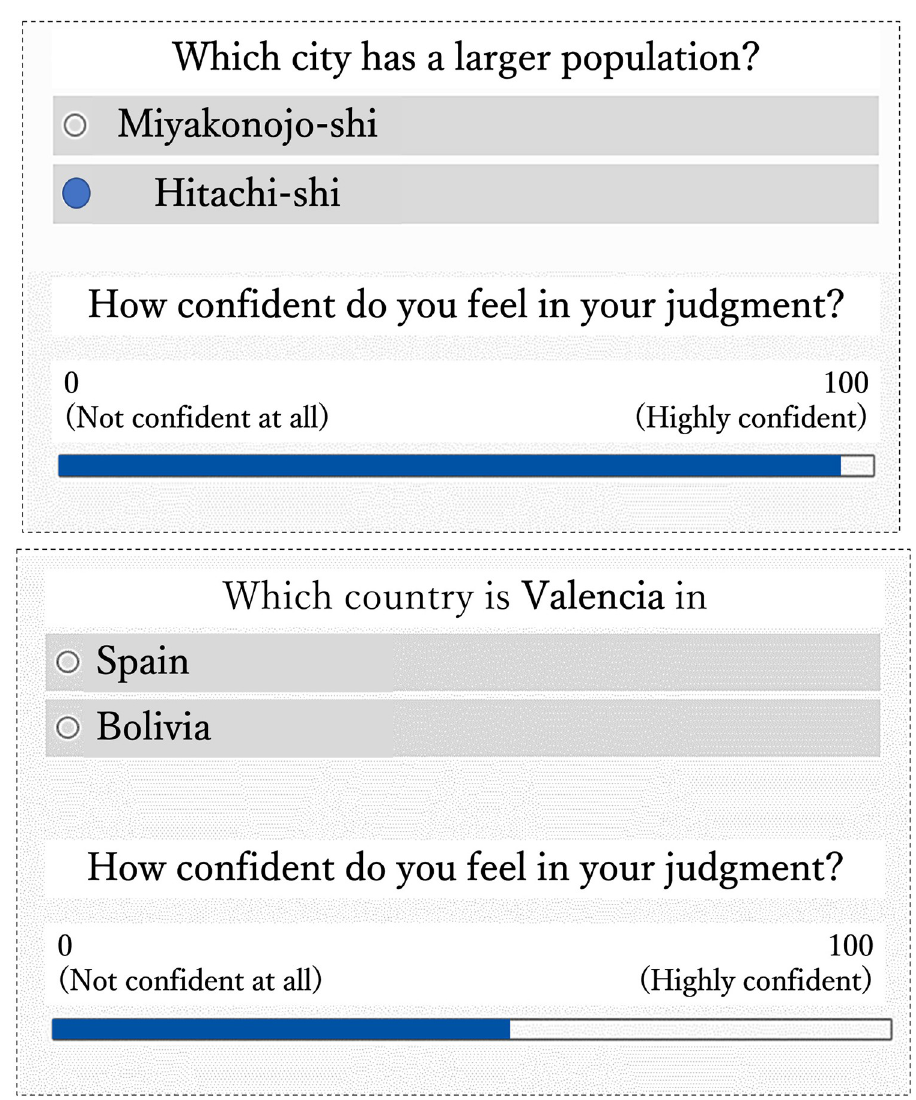
Fig 2. Examples of a population inference task (upper) and relationships comparison task (lower). In both tasks, participants were asked to choose one of the two alternatives, and then to rate their confidence for the judgment. Note: In our experiment, all descriptions were displayed in